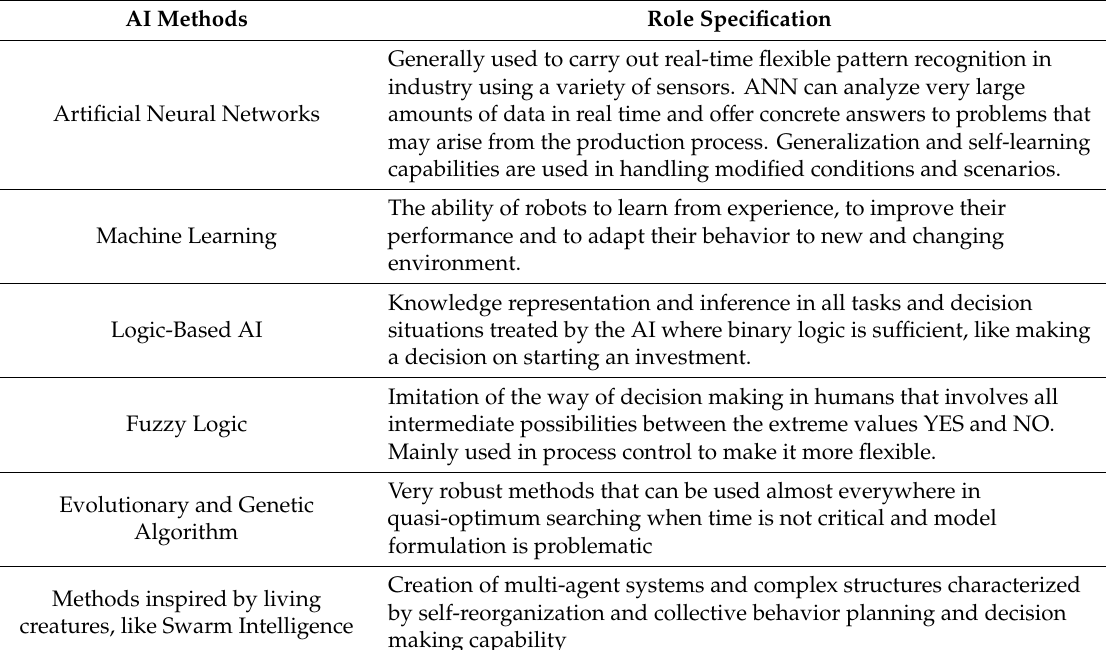
Table 2. AI methods and their possible use in Industry